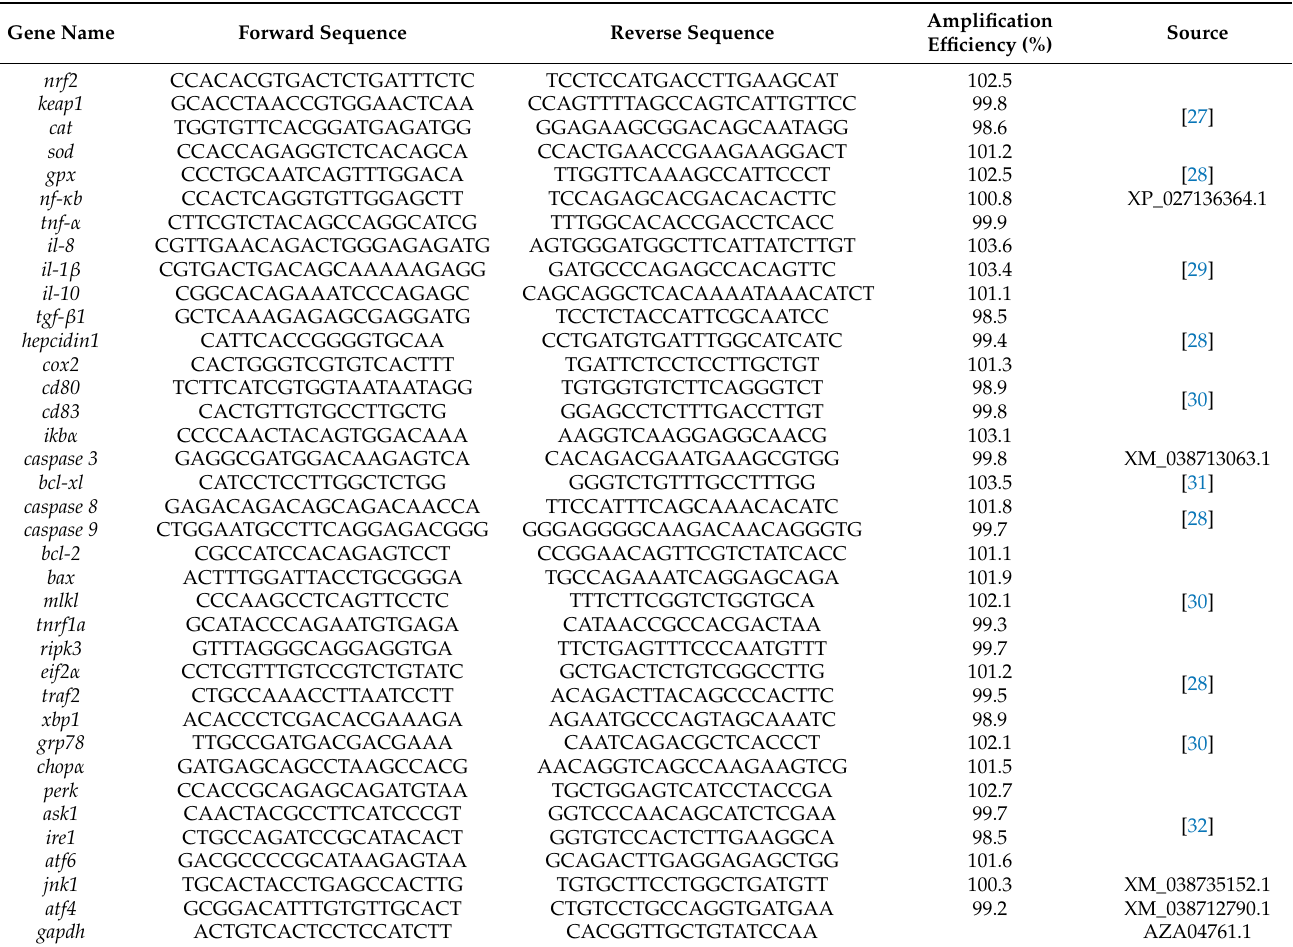
Table 2. Primer sequences for